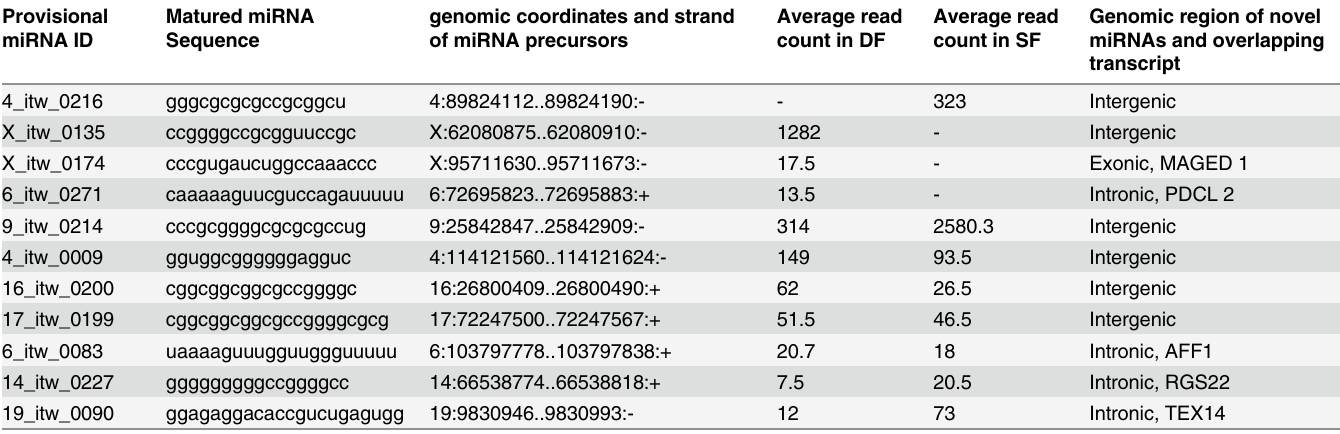
Table 6. Predicted novel miRNAs expressed in granulosa cells of preovulatory dominant and/or subordinate follicles. Provisional miRNA